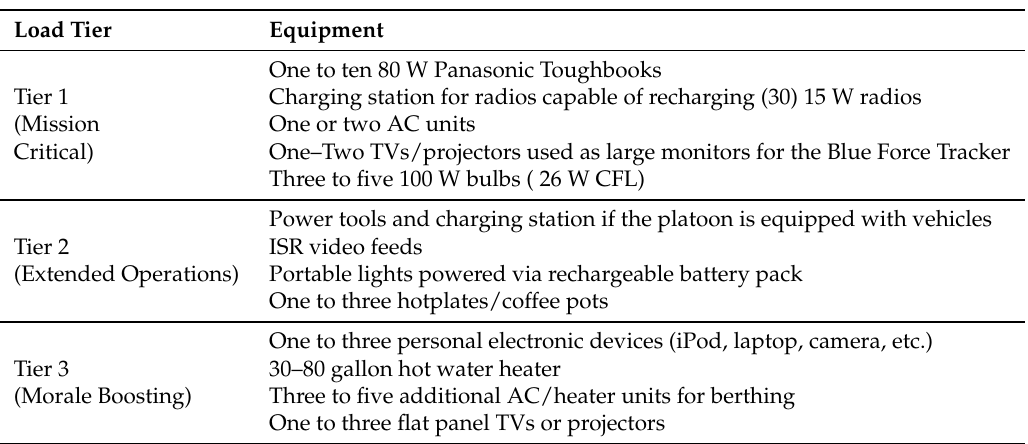
Table 1. Equipment included in each load tier at a Patrol Base.